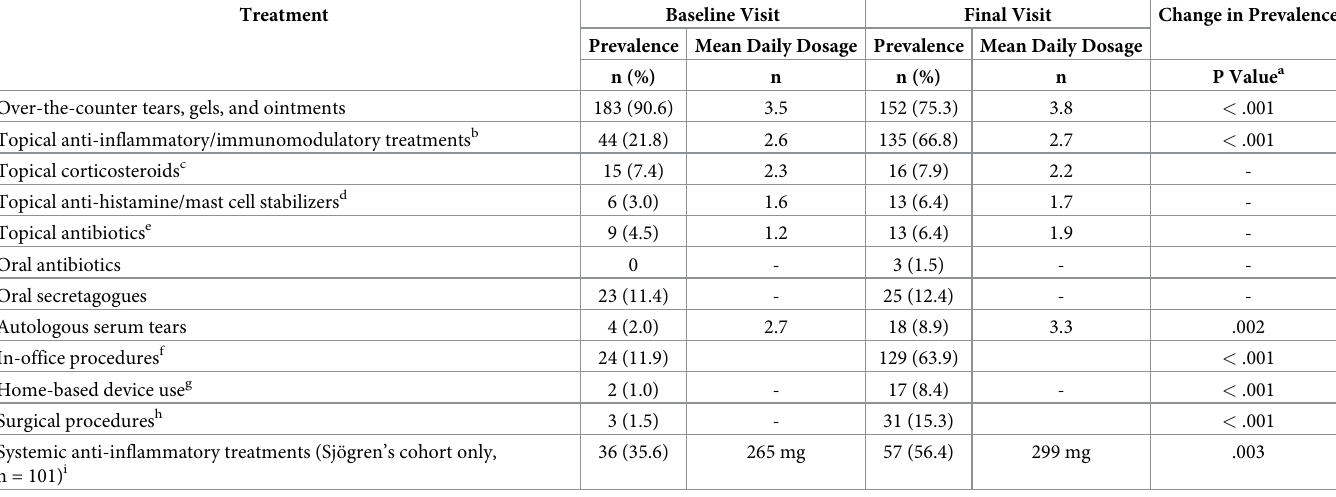
Table 4. Dry eye treatment prevalence and dosage frequency at baseline versus final visit for a longitudinal, clinic-based sample of patients with Sjo¨gren’s and non- Sjo¨gren’s dry eye disease.